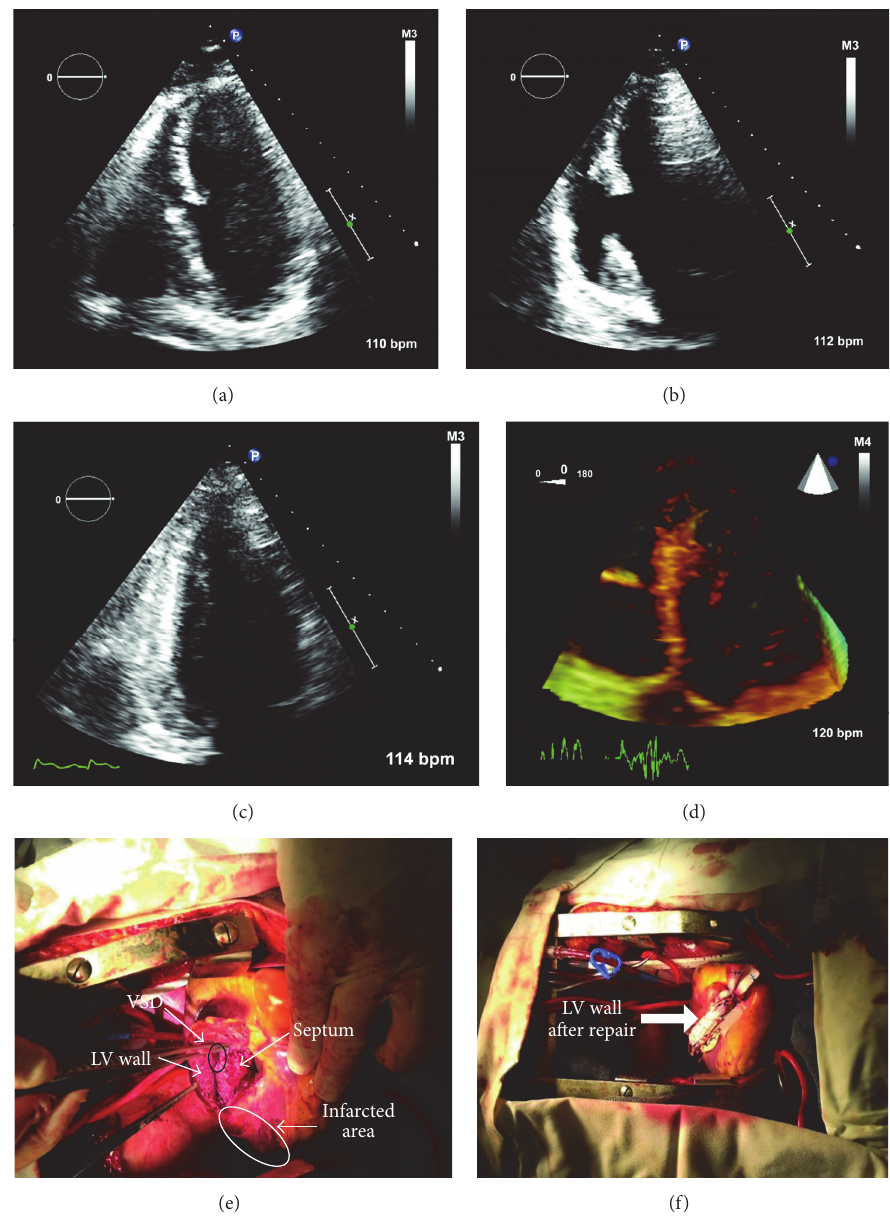
Figure 1: Four-chamber echocardiographic views of an apparent ventricular septal defect of the inferior septum (a) and an apparent pseudoaneurysm of the inferior wall (b), which persisted despite rotating the transducer 90 degrees or more from the four-chamber apical window. On repeat imaging, a very narrow apical window was identified in which the two-chamber view was seen without the pseudoaneurysm (c). Also shown is a three-dimensional echocardiographic depiction of the serpiginous nature of the ventricular septal dissection (d). Surgical view of the infarcted area and partial ventricular septal defect (e). Surgical view of the septum covered by a Dacron patch